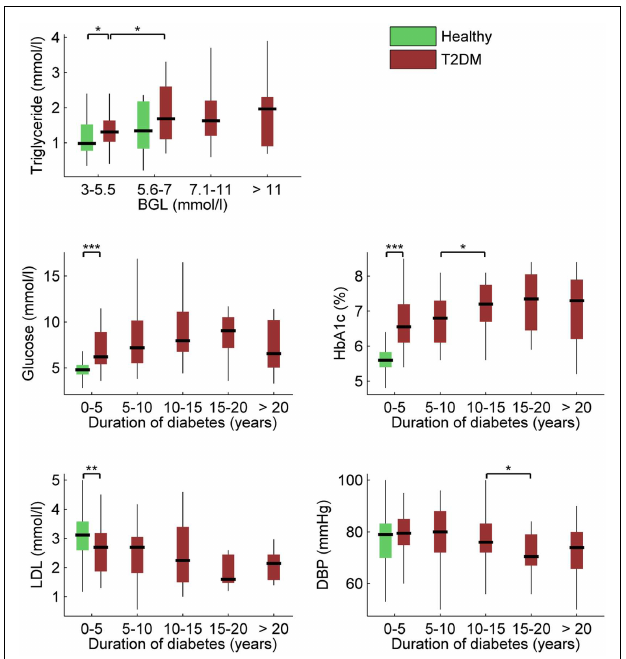
FIGURE 3 | Box plots of most significant associations between clinical characteristics, BGL, HbA1c, and duration of diabetes (*** p ≤ 0.001; ** p ≤ 0.01; * p ≤ 0.05) . Descriptions as in Figure 2 .